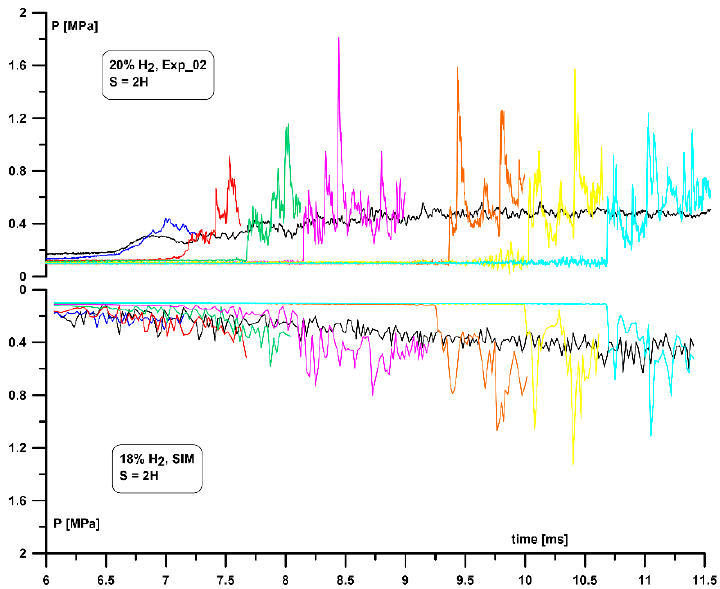
Figure 11. Experimental (top) and numerical (bottom) pressure profiles with deflagration for case S = 2H. Sequence of sensors activation corresponds to the sensors position as in Figure 1. Same colors apply to sensors in the same position. Simulation time shifted +5.5 ms for better visibility.